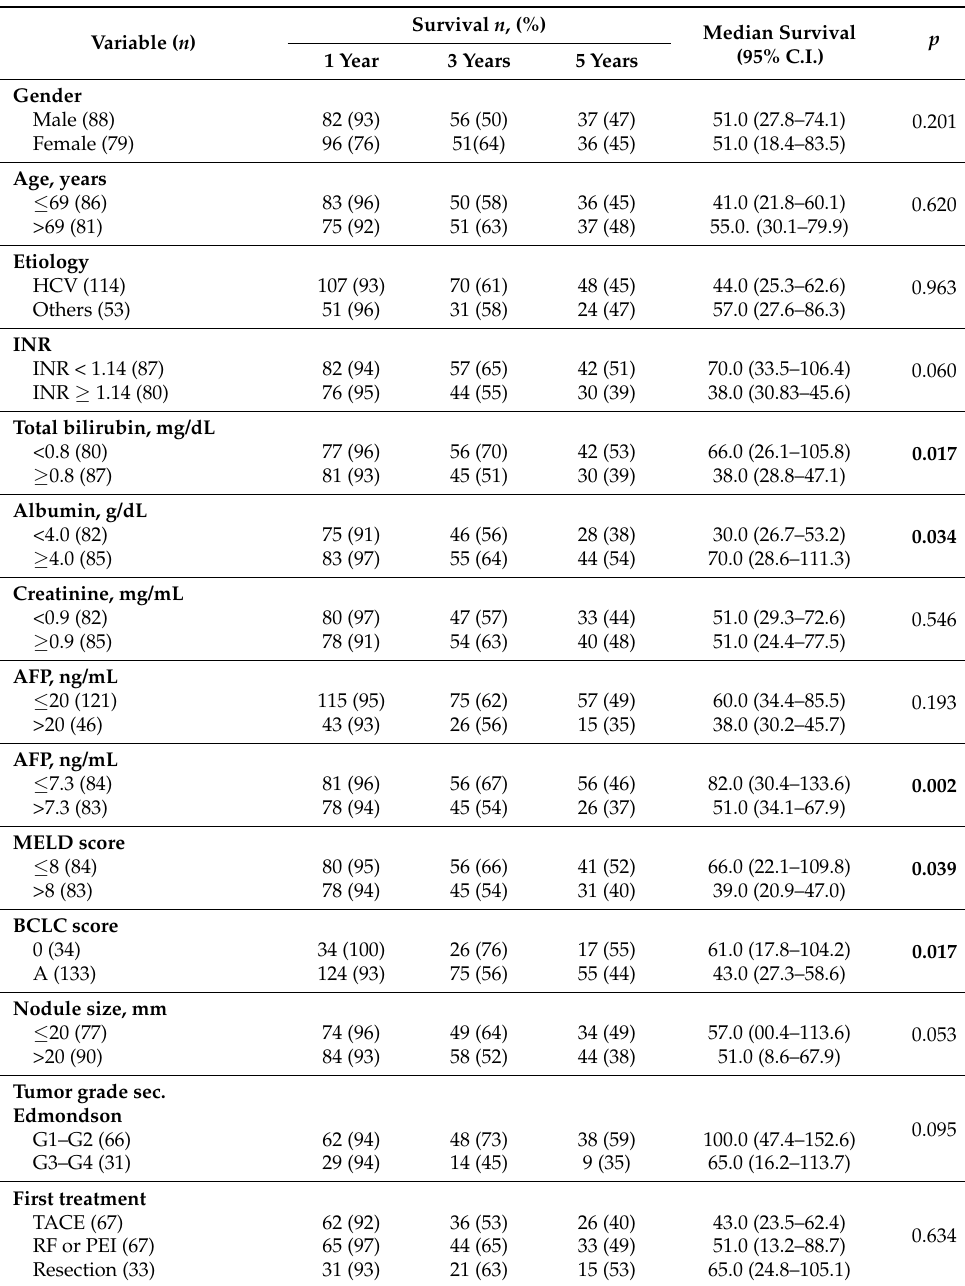
Table 4. Univariate survival